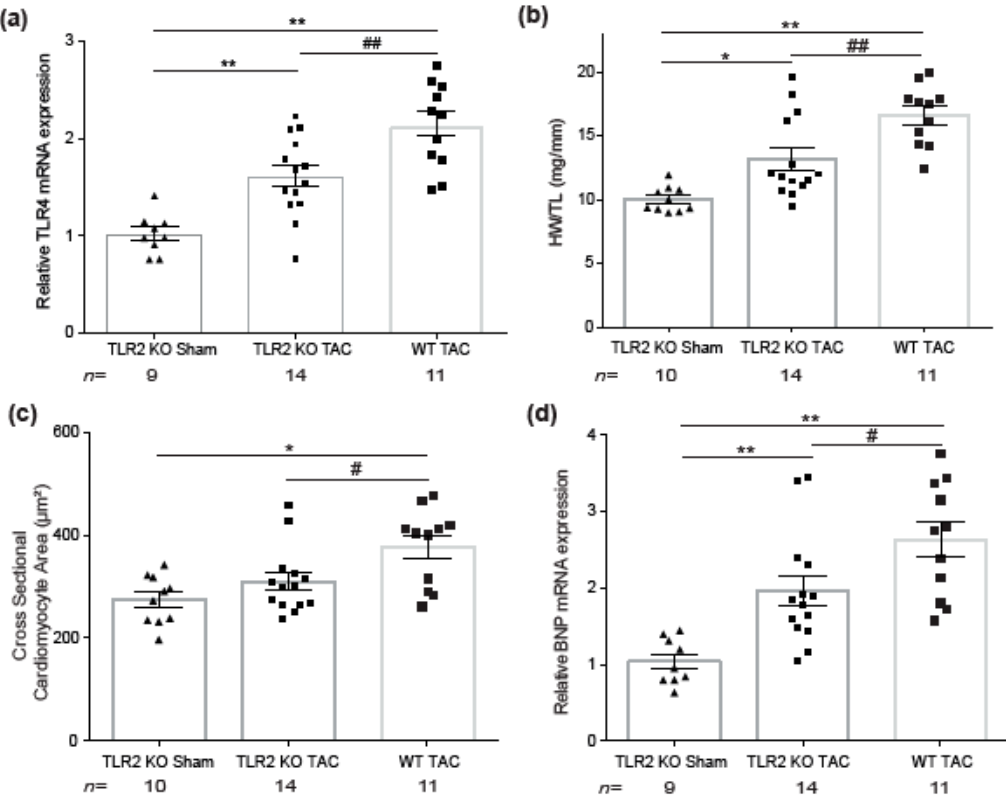
Figure 3. TLR4 and hypertrophic parameters in TLR2 KO and WT mice 12 weeks after sham or TAC surgery. ( a ) Relative mRNA expression of TLR4 assessed by TaqMan RT-qPCR. ( b ) Heart weight to tibia length ratio (HW/TL, mg/mm). ( c ) Cross-sectional cardiomyocyte area ( µ m 2 ) assessed by fluorescent dystrophin labeling. ( d ) Ventricular mRNA expression of brain natriuretic peptide (BNP) assessed by TaqMan RT-qPCR. n indicates the number of mice per group. For TLR4, HW/TL, and BNP, a one-way ANOVA followed by Tukey’s test was used, and for the cross-sectional cardiomyocyte area, a one-way ANOVA followed by Tukey’s test on the log was used: * p < 0.05, ** p < 0.01, # p < 0.05 and ## p < 0.01. Table 2 . Tissue characteristics of TLR2 KO sham, TLR2 KO TAC and WT TAC mice 12 weeks after surgery. Values are mean ± SEM. TAC, transverse aortic constriction; KO, knockout; WT, wild type; n, number of animals; HW/TL, heart weight to tibia length ratio; LuW/TL, lungs weight to tibia length ratio; LiW/TL, liver weight to tibia length ratio; KW/TL, average kidney weight to tibia length ratio. * p < 0.05 and ** p < 0.01 compared to TLR2 KO sham; # p < 0.05 and ## p < 0.01 compared to TLR2 KO TAC.